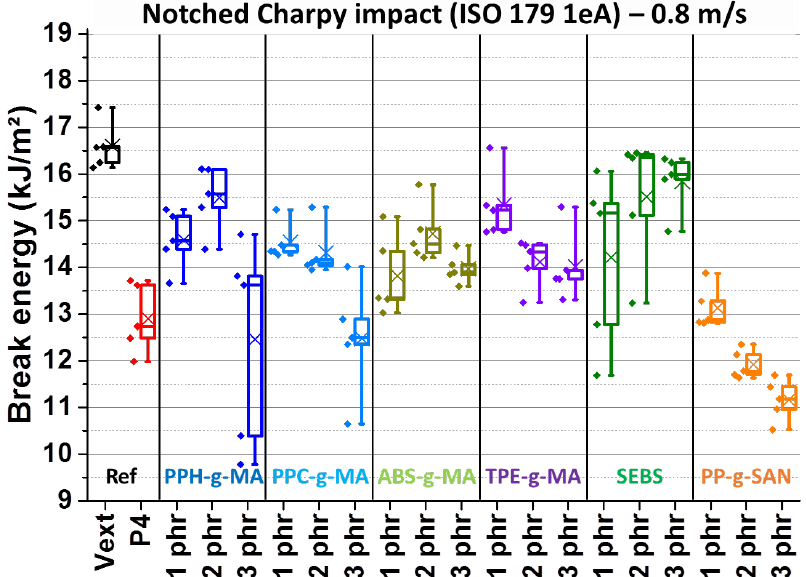
Figure 9. Notched Charpy impact break energies—virgin extruded ABS batch “Vext”, 4 wt% PP contaminated batch “P4”and separately added batches with 1, 2 and 3 phr of PPH-g-MA, PPC-g-MA, ABS-g-MA, TPE-g-MA, SEBS and